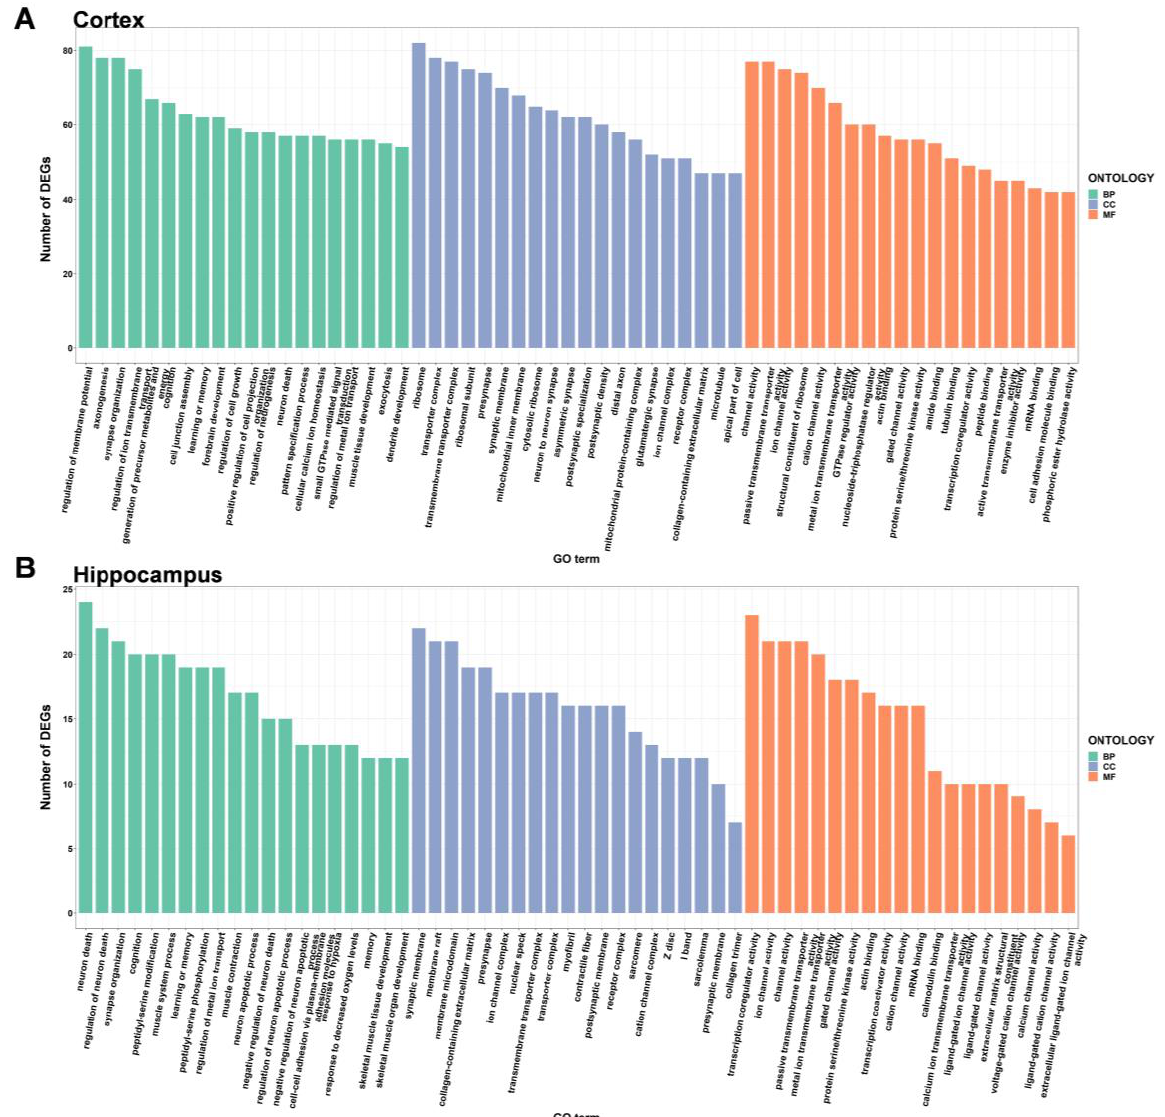
Figure 4. Gene ontology enrichment analysis of the DEGs in the cerebral cortex ( A ) and hippocampus ( B ) of male DAPK1-KO mice. The GO categories were biological process (BP), cellular component (CC), and molecular function (MF).